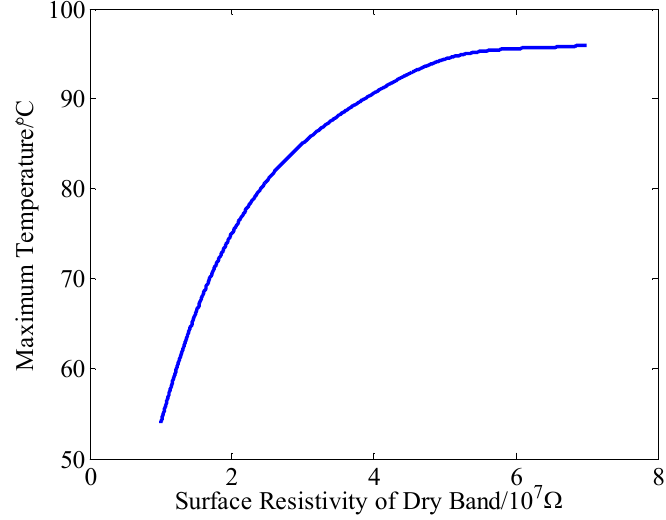
Figure 9. Numerical simulation of the maximum temperature curve of insulators.